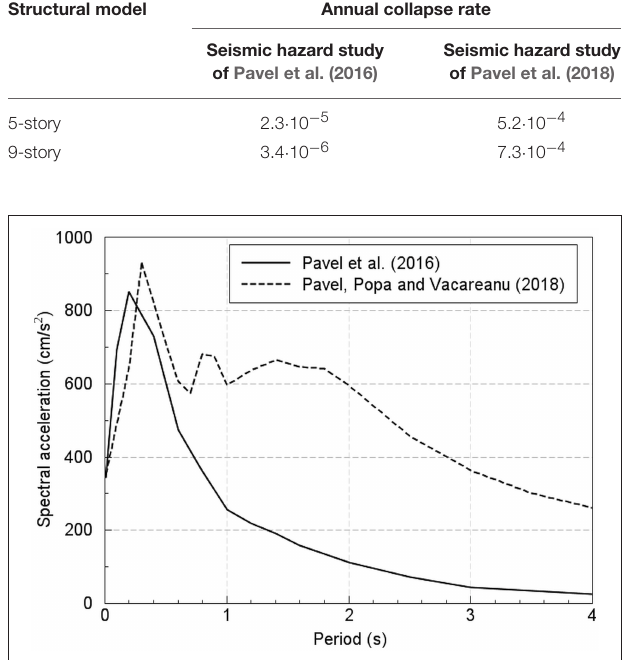
FIGURE 7 | Comparison of uniform hazard response spectra for Bucharest obtained in two studies (mean return period = 475 years).